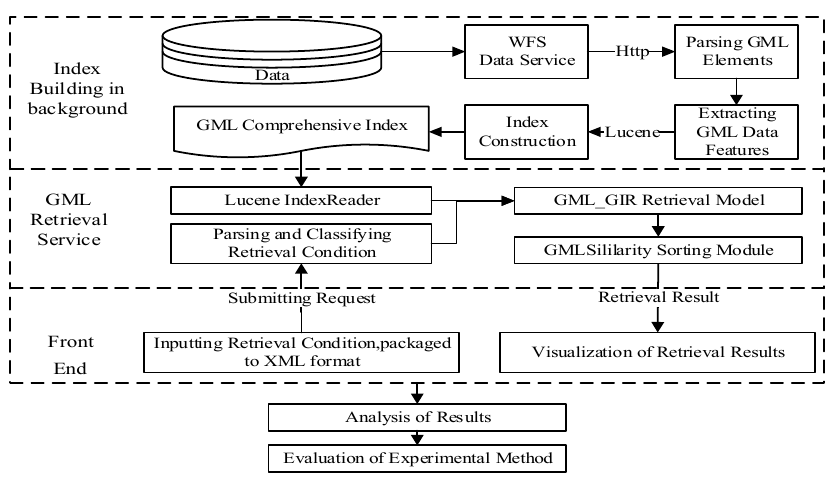
Figure 8. Experimental procedure.